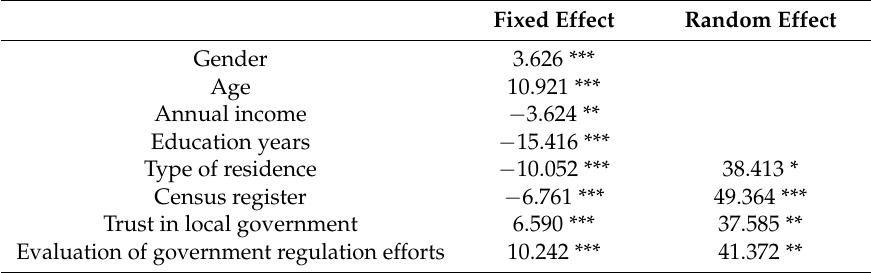
Table 4. Fixed effect and the random effect of resident-level